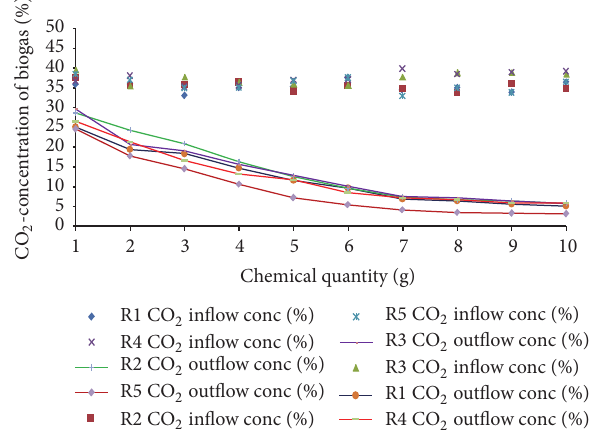
Figure 2: CO 2 inflow versus outflow concentration of biogas under the treatments of runs R1, R2, R3, R4, and